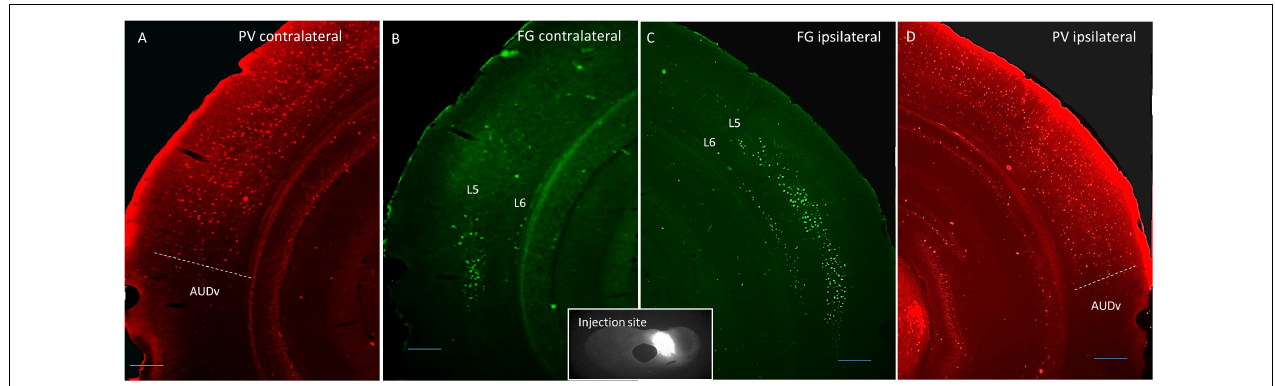
FIGURE 1 | Coronal images showing an example DC injection site (inset), and the corresponding contralateral Fluorogold label (B) , ipsilateral Fluorogold label (C) , and PV immunostaining pattern (A,D) . Scale bar = 250 µ m. L5 = layer 5, L6 = layer 6, AUDv, ventral auditory region.